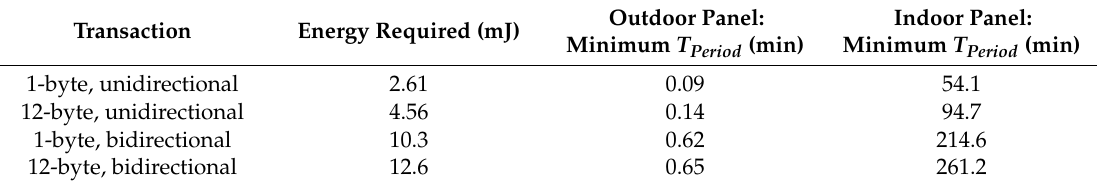
Table 4. Energy required and minimum feasible T Period for different types of transactions, for the two energy harvesting sources considered, and for an uplink bit rate of 100